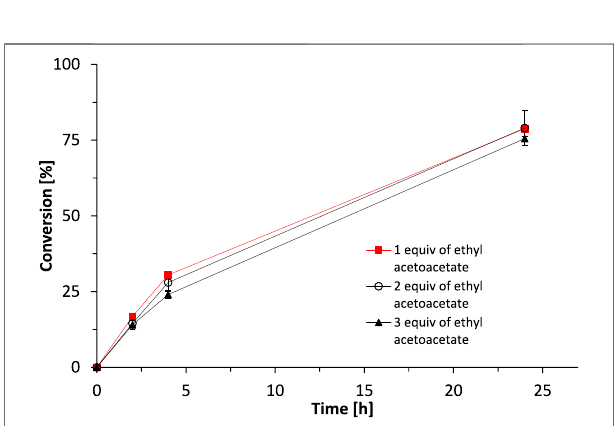
FIGURE5| Thein fl uenceofsubstrate/cosubstrateratioontheactivityof Sy ADH catalysed oxidation of rac -heptan-2-ol in a biphasic reaction system. Reaction conditions: [ rac -heptan-2-ol] org = 50 mM, [Ethyl acetoacetate] org = 50, 100 or 150 mM (1 – 3 equiv.), [NADP + ] aq = 1 mM, [ E. coli C43(DE3) pET24b- syadh ] = 10 mg×mL − 1 , [KPi, pH 7] = 1 M (10% v/v), [ n- heptane] = 90% v/v, total volume: 500 μ L, T = 30 ° C, 600 rpm. Data are expressed as the mean ± SD of the two independent experiments performed in technical duplicates.